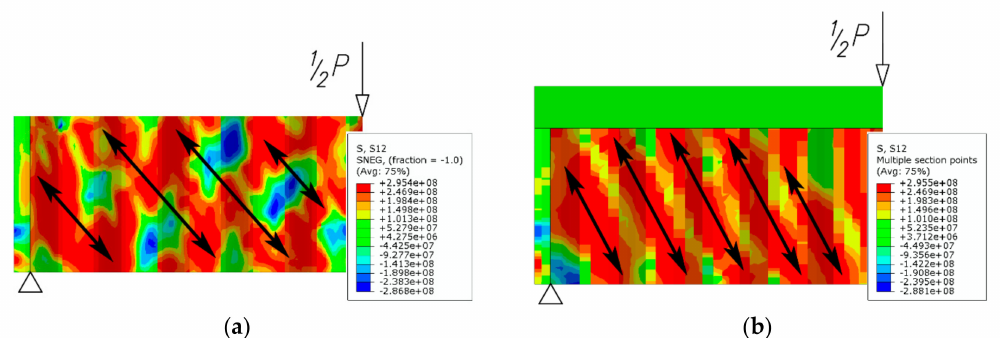
Figure 15. Final post-buckling shear stress distribution in the sinusoidal web (unit: Pa): ( a ) steel beam; ( b ) beam bonded to a reinforced concrete slab.